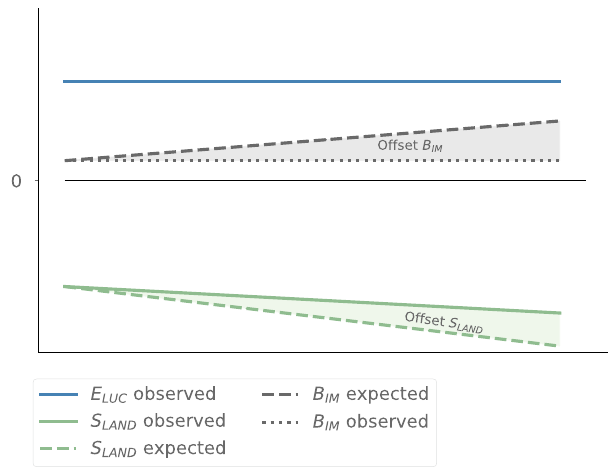
Fig. 4 | Simpli fi ed scheme of the implications of not considering synergies betweenenvironmental effects oncarbon stocks and E LUC . Trends of each term are assumed to be linear for simplicity, which is not representative of the real dynamics. Solid lines represent how environmentaleffects, suchasincreasing CO 2 concentrations, on each term (i.e., increase or decrease) are considered in current carbonbudgetapproaches,suchastheGlobalCarbonBudget(GCB) 7 .Dashedlines show the expected trends if the effect of the increasing natural terrestrial carbon sink( S LAND )duetoenvironmentaleffectsoncarbonstockswereincludedincurrent approaches. Solid lines, termed “ observed ” , show how environmental effects on carbon fl uxes from land-use and (land-use induced) land cover change activities ( E LUC ) and on S LAND are considered in current approaches. The B IM in current approachesisshownasdottedline(B IM observed). E LUC ( E LUC observed)isshownas a constant (excluding variability due to LULCC), because the bookkeeping models used in the GCB assume time-invariant carbon densities. Considering that the increasein